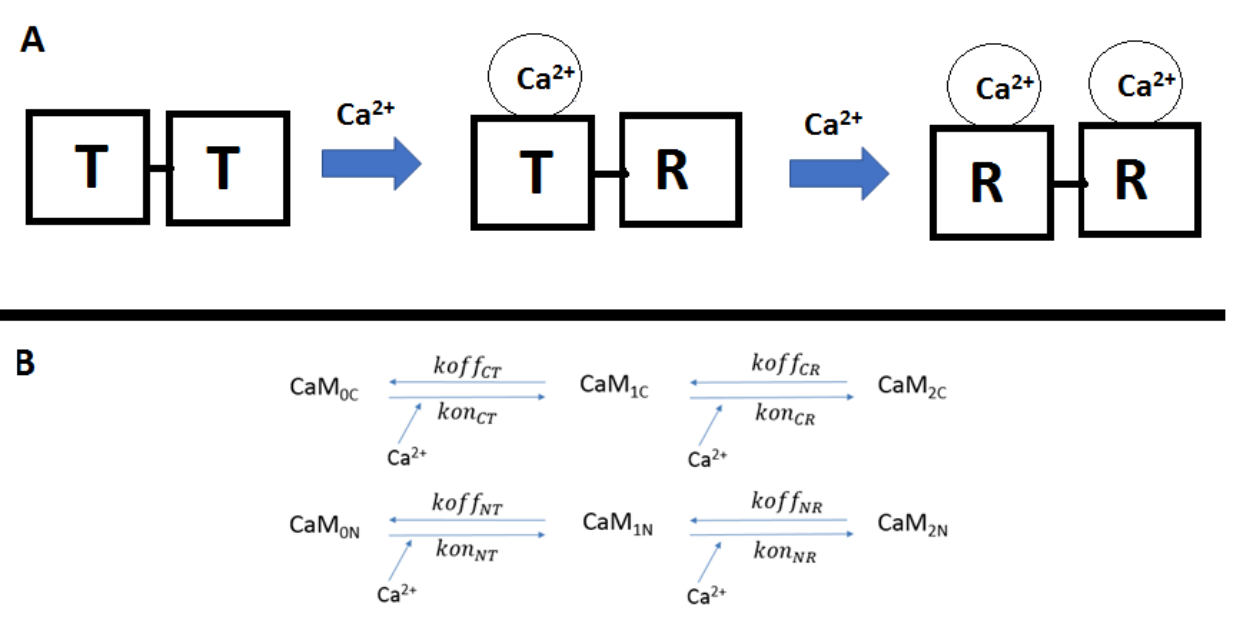
Figure 1. The top figure ( A ) shows how binding of Ca 2+ hands EF-hands (depicted as black squares) causes the neighboring EF-hand to transition from a tense (T) to a relaxed (R) state. ( B ) Labels above the arrows indicate the parameters pertaining to each reaction. Variables are given in Table 1. Table 1. CaM states in the model.